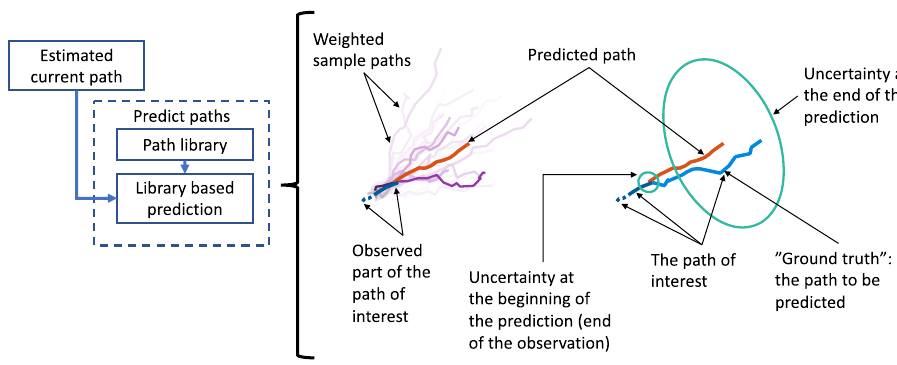
Figure 4: The predicted path is the weighted sum of the most similar library paths.